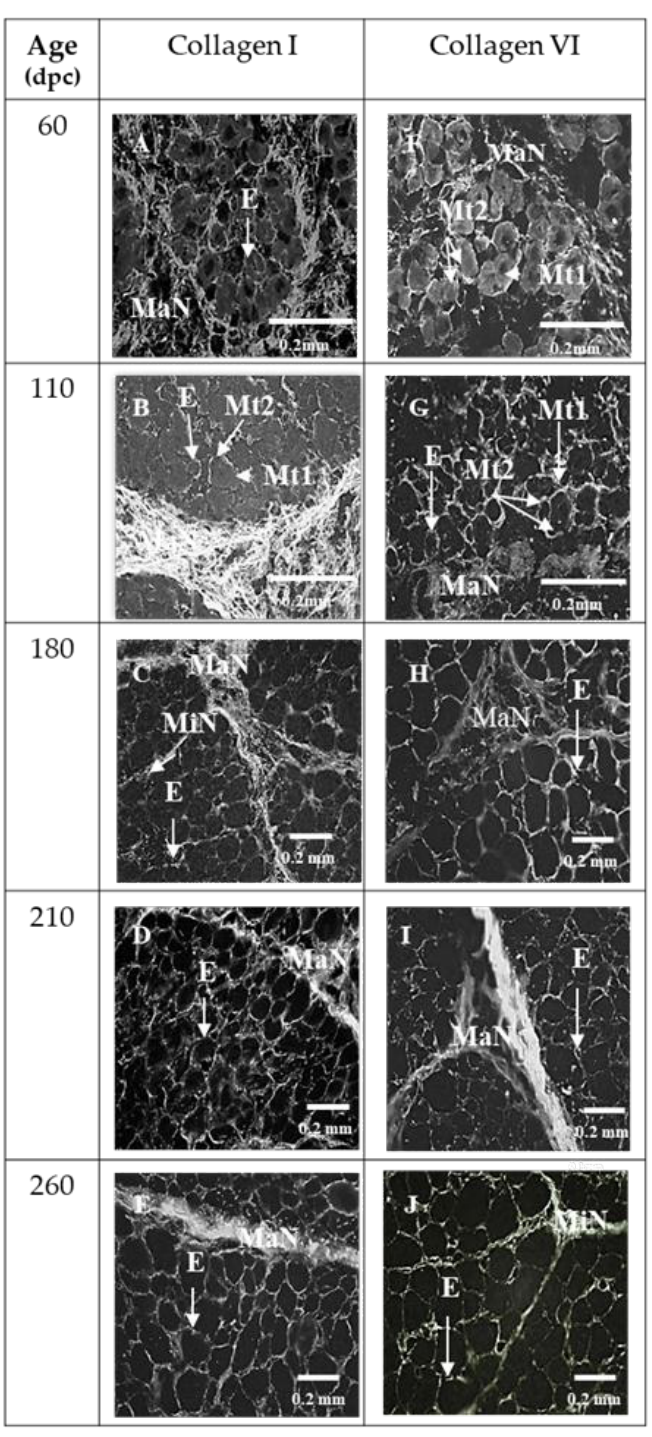
Figure 2. Immunohistochemical labelling with antibodies against type I ( A , B , C , D , E ), and type VI ( F , G , H , I , J ) collagens of transverse sections of foetal Semitendinosus muscle at 60, 110, 180, 210 and 260 days post-conception (dpc) (Major (MaN) and minor (MiN) networks of perimysium; E: endomysium, Mt1: primary myotubes, Mt2: secondary myotubes).